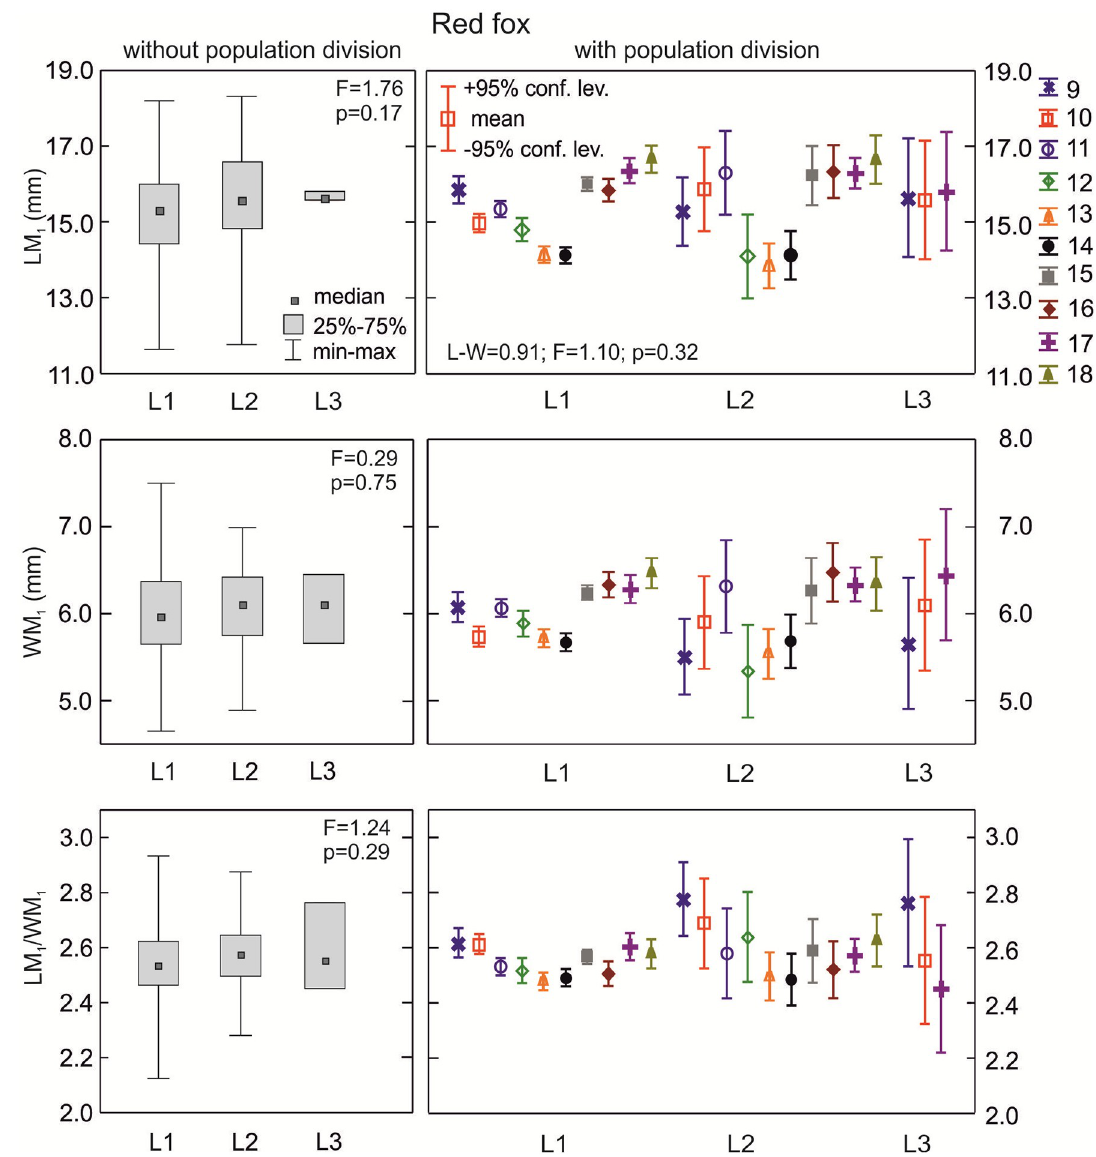
Fig 8. Comparison of median values for length, width, and size proportion of M 1 between various group L morphotypes in the red fox with and without population division. Illustrations of group L morphotypes are shown in Fig 2 Information about the samples can be found in Table